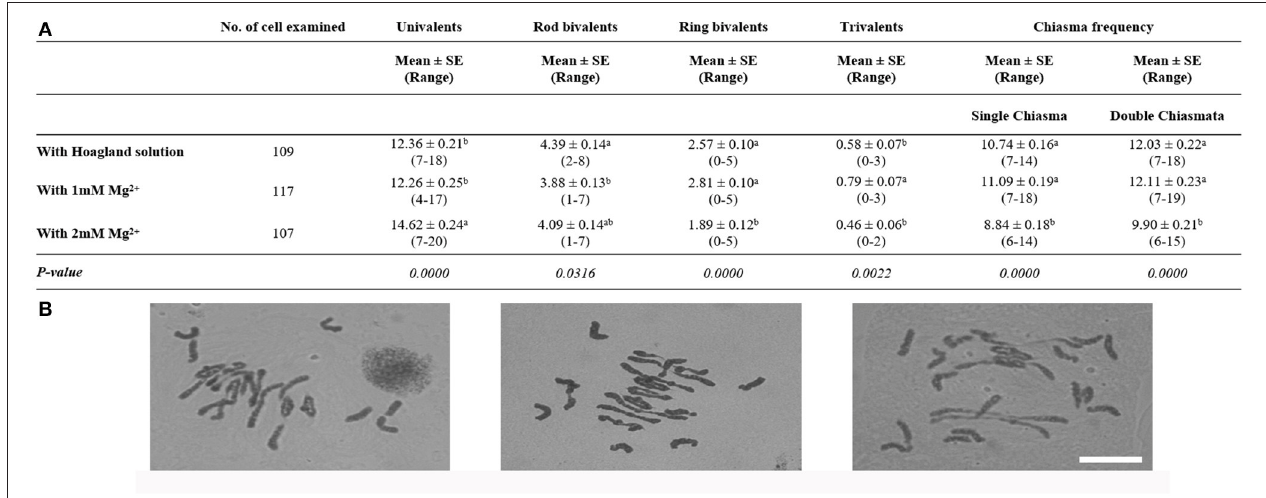
FIGURE 1 | Effect of either 1mM or 2mM Mg 2 + on homoeologous CO frequency of T. aestivum cv. Chinese Spring Tazip4-B2 ph1b mutant-rye hybrids. (A) Frequencies of univalents, bivalents, trivalents, and chiasma frequency (single and double chiasmata) were scored at meiotic metaphase I in Tazip4-B2 ph1b mutant-rye hybrids treated with either Hoagland solution, 1mM Mg 2 + or 2mM Mg 2 + solution. Values in parenthesis indicate range of variation between cells. P < 0.05 indicates significant differences according to LSD test. Different letters indicate significant differences between treatments. (B) Representative meiotic configurations of Tazip4-B2 ph1b mutant-rye hybrids. From left to right: treatment with Hoagland solution, 1mM Mg 2 + or 2mM Mg 2 + solution. Bar: 20 µ m.